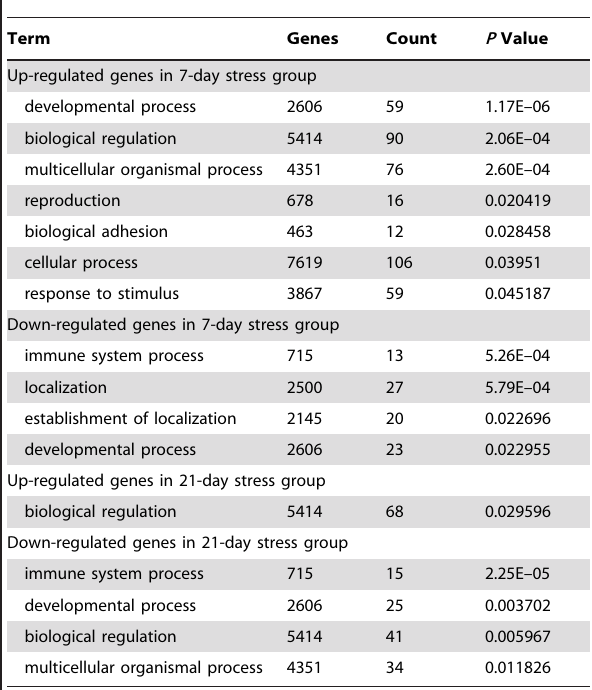
Table 1. Classification of the up-regulated and down- regulated genes involved in the significant bioprocesses of the 7-day and 21-day stress groups in comparison with the control